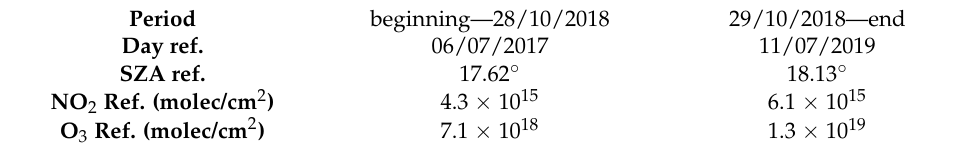
Table 1. Reference spectra in the two different periods used for QDOAS analysis.